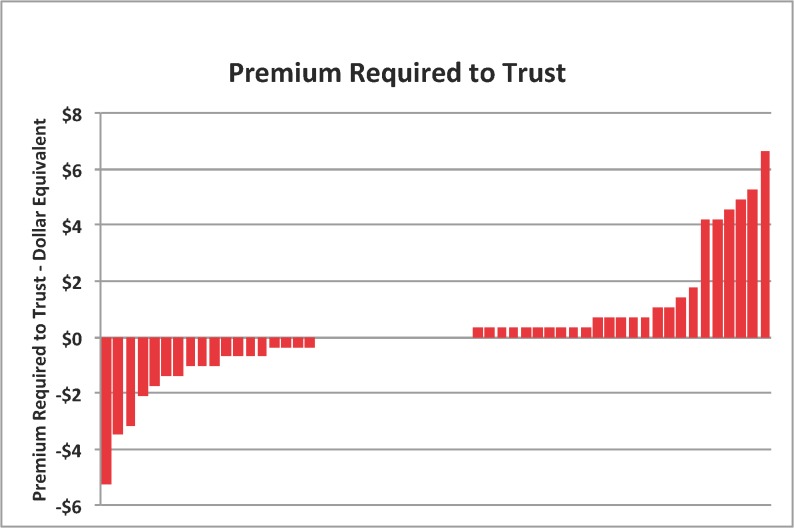
The figure illustrates the monetary premium each participant reported requiring in order for them to choose to trust a randomly matched trustee counterpart, ordered from the most Betrayal Seeking participant to the most Betrayal Averse.This premium is calculated as the extra probability required (or sacrificed) in order to trust, compared to the risk game (MAP difference), multiplied by the excess earnings that would result from the expected additional level of reciprocation.